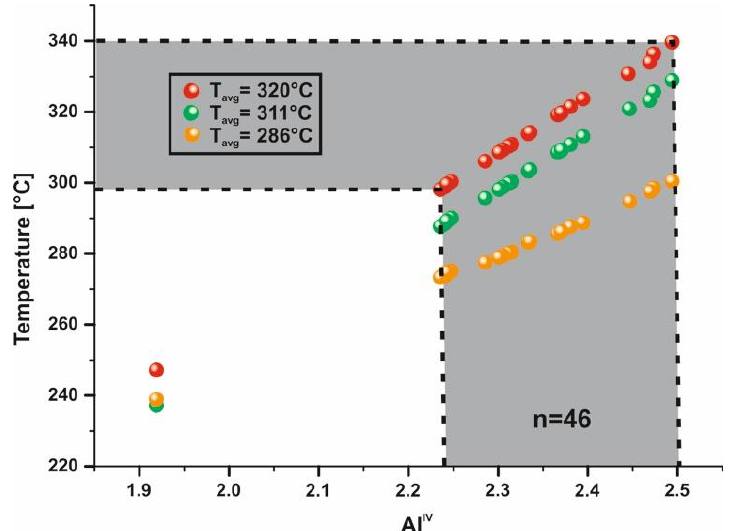
Figure 5. Al IV vs. temperature plot for the chlorites investigated in this study. Temperatures is based on three geothermometers: [42] (red), [43] (green), and [44] (orange).